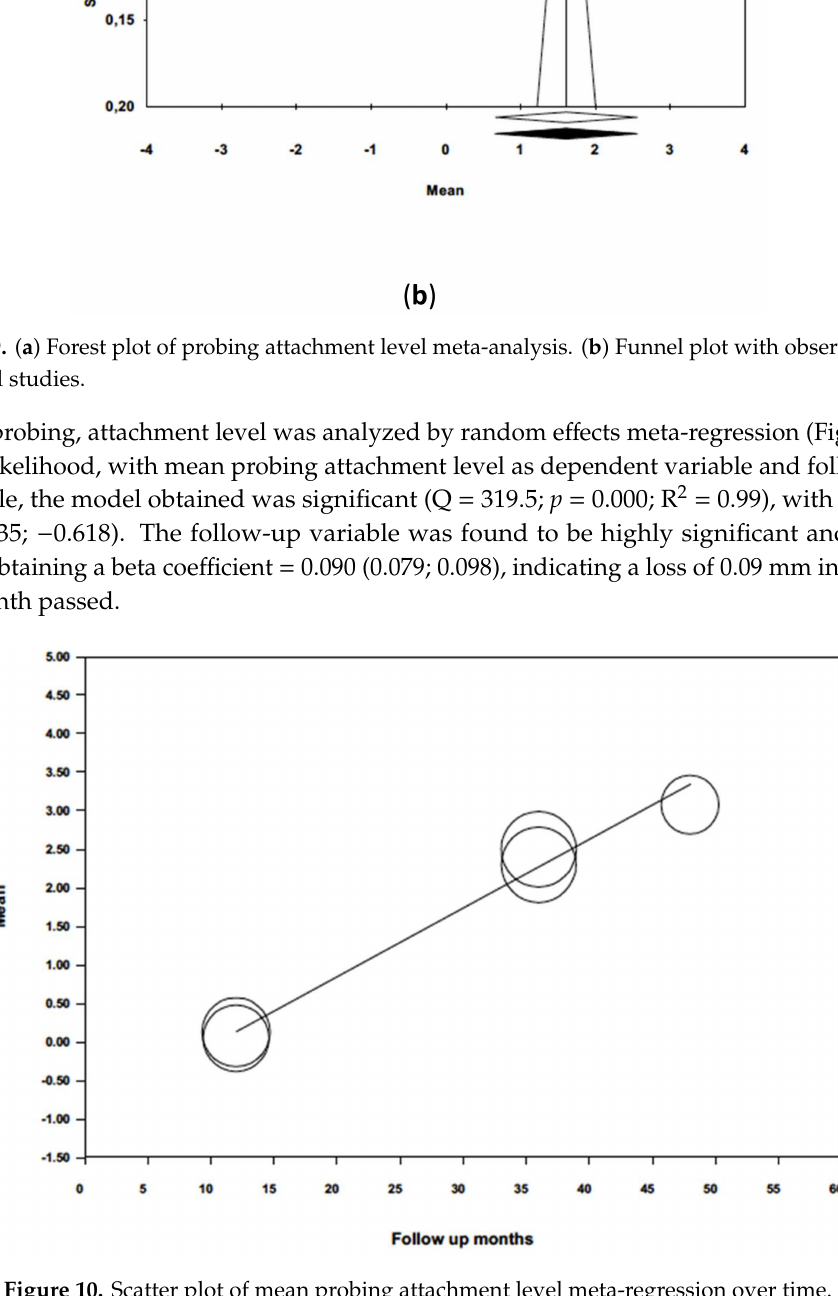
Figure 10. Scatter plot of mean probing attachment level meta-regression over